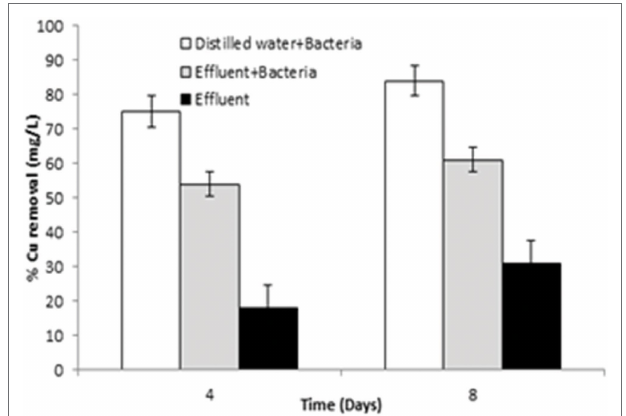
FIGURE 4 | Graph of pilot scale study for biosorption of Cu (10 mg/l) by B. altitudinis MT422188 after 4 and 8 days, respectively.